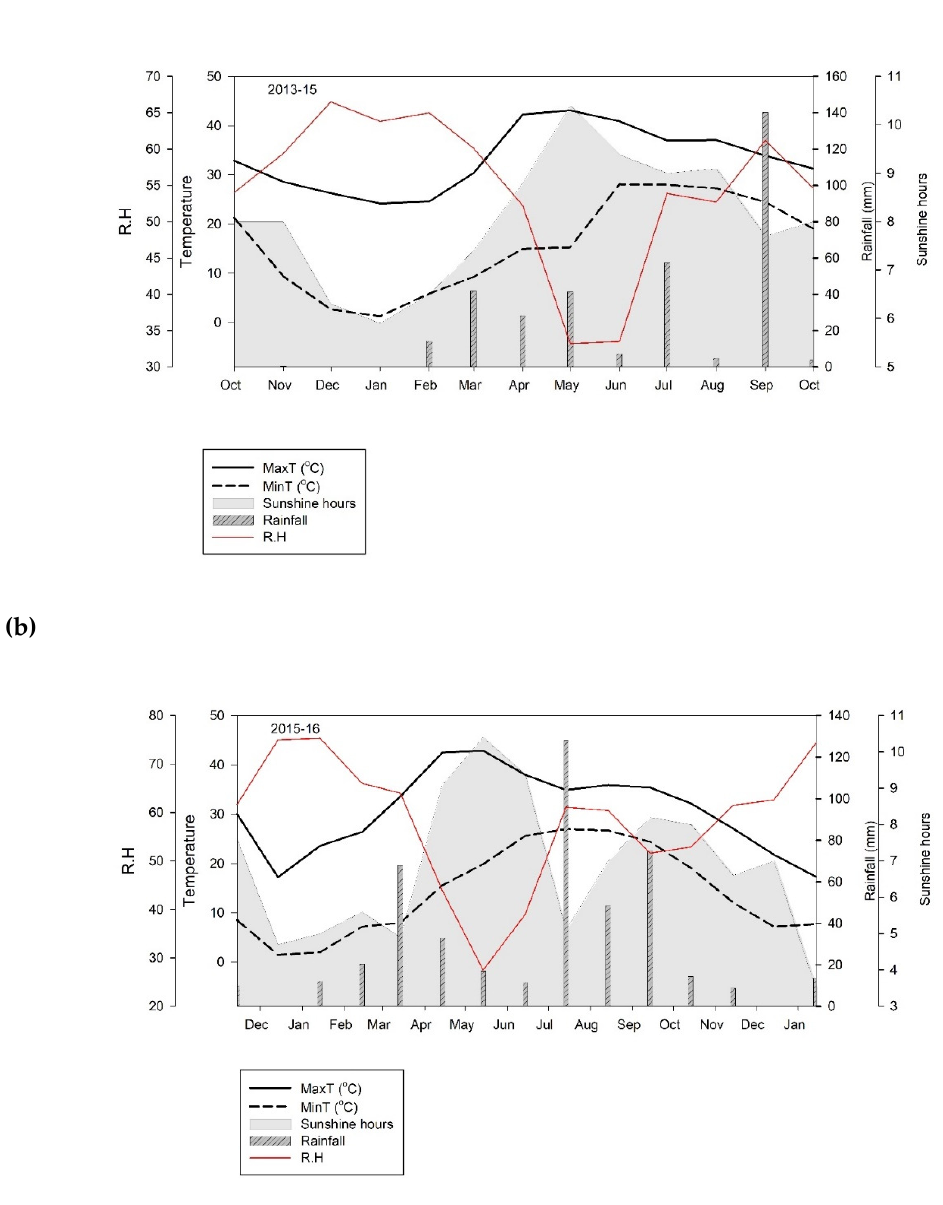
Figure 1. Meteorological data during. ( a ) Plant crop and ( b ) ratoon crop seasons of sugarcane.